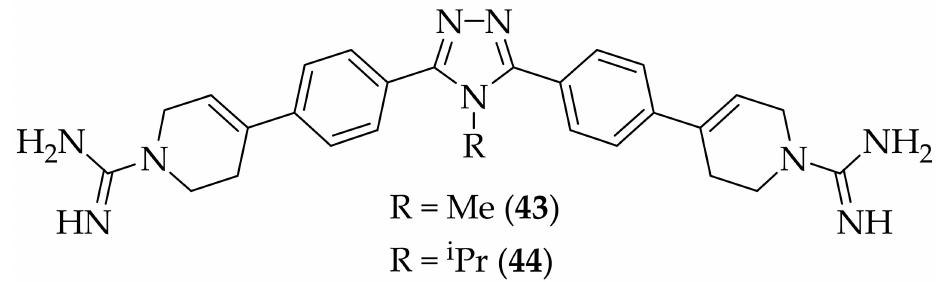
Figure 28. 1,2,4-triazole bis-guanidine-containing antifungal derivatives ( 43 ) and ( 44